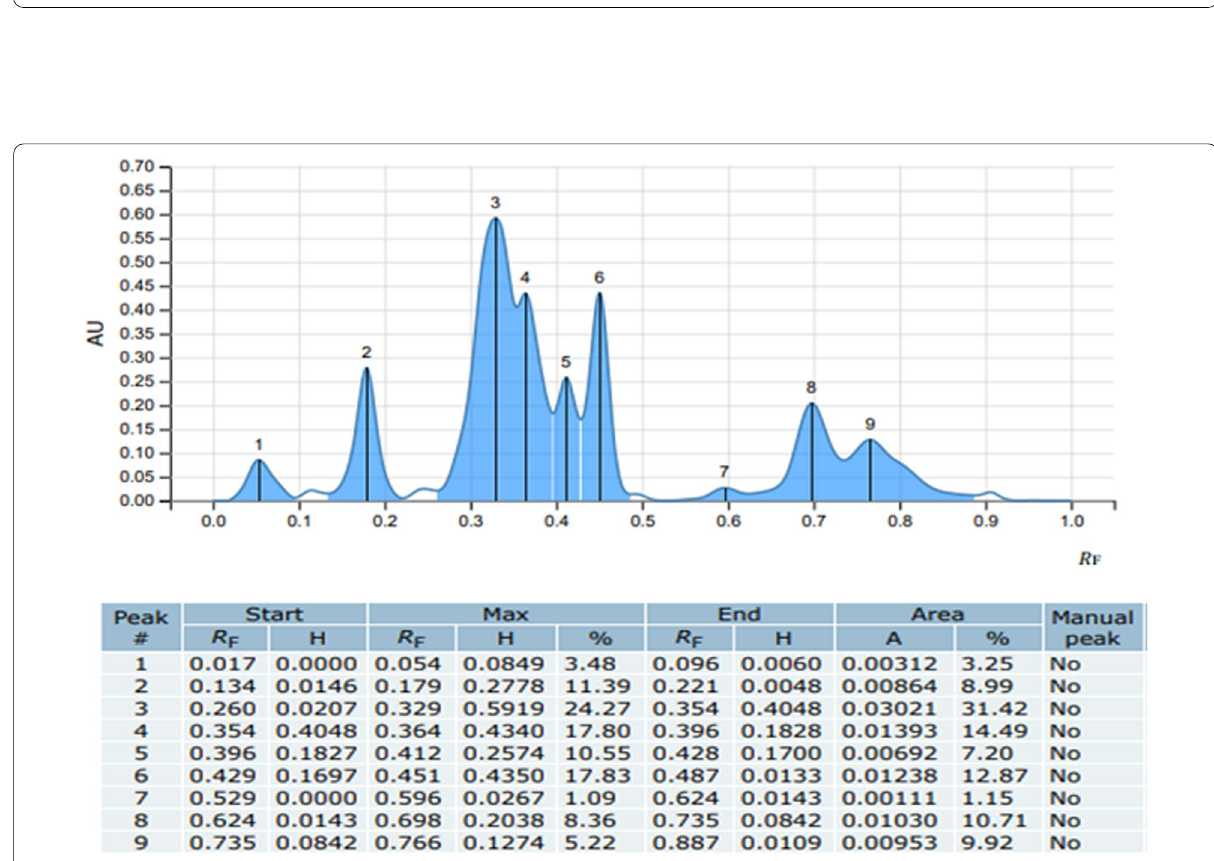
Fig. 6 Peak chromatogram band of E. indicum aqueous extract using the solvent system B (ethyl acetate/methanol/ammonia 28–30% in the ratio of 40:10:10)